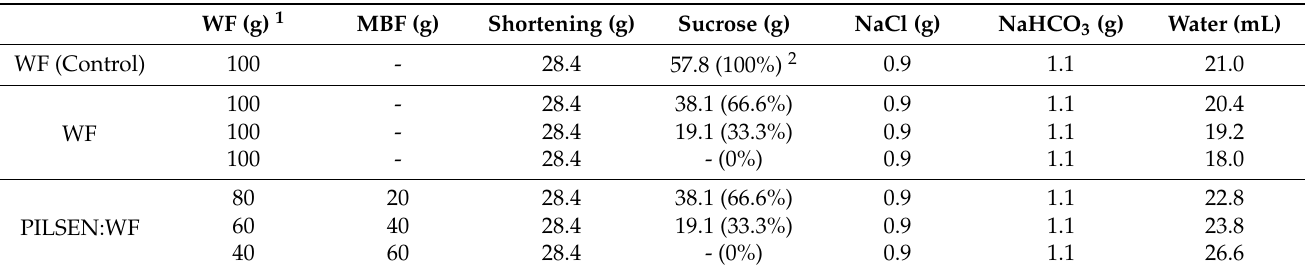
Table 4. Formulation of MBF:WF